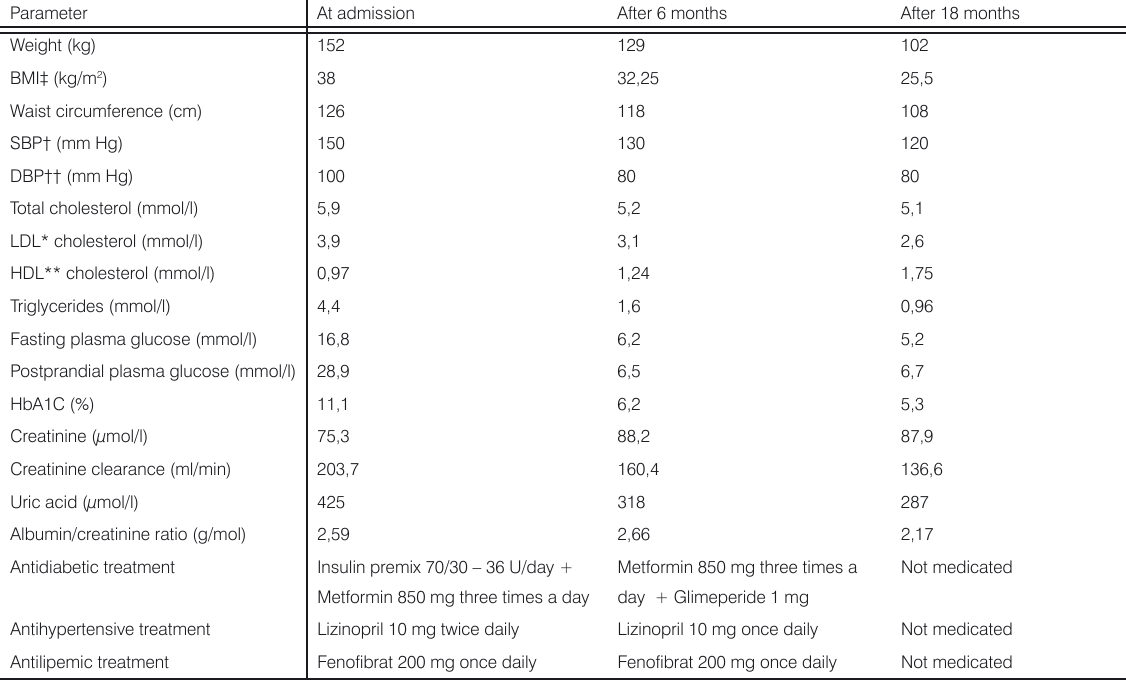
Table 1. Anthropometric parameters, blood pressure, laboratory data, renal function parameters and drug therapy changes observed at admission, 6 and 18 months later.